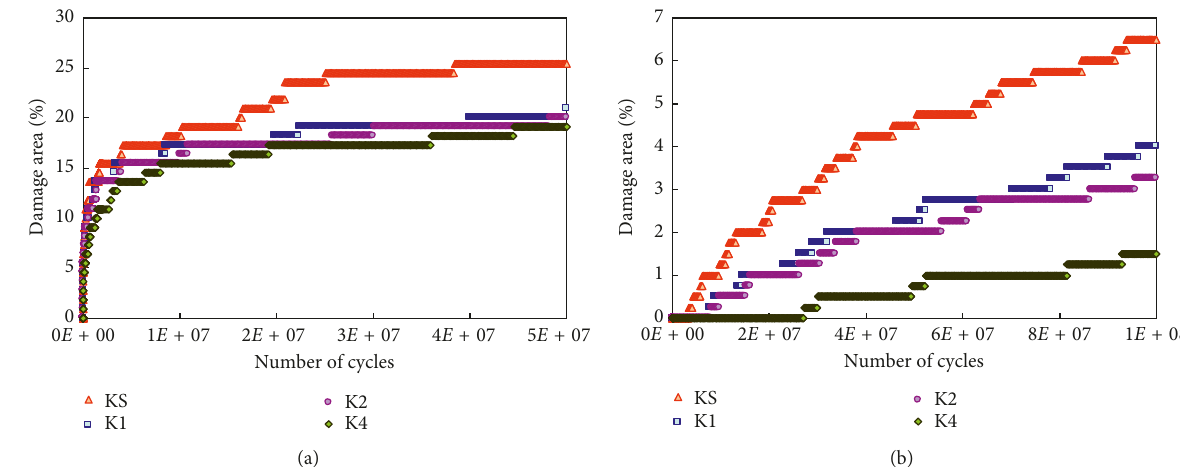
Figure 10: Damage area (%) along number of cycles for (a) thin pavement and (b) thick pavement. Table 8: Modified contour plots of C for thin pavements in color mode. Thin pavement Number of cycles